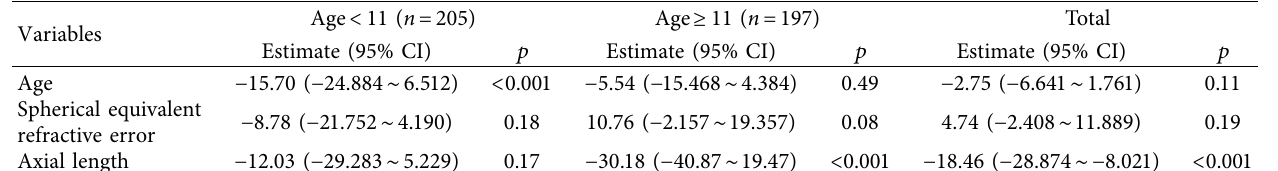
Table 4: Factors associated with central foveal choroid in myopic